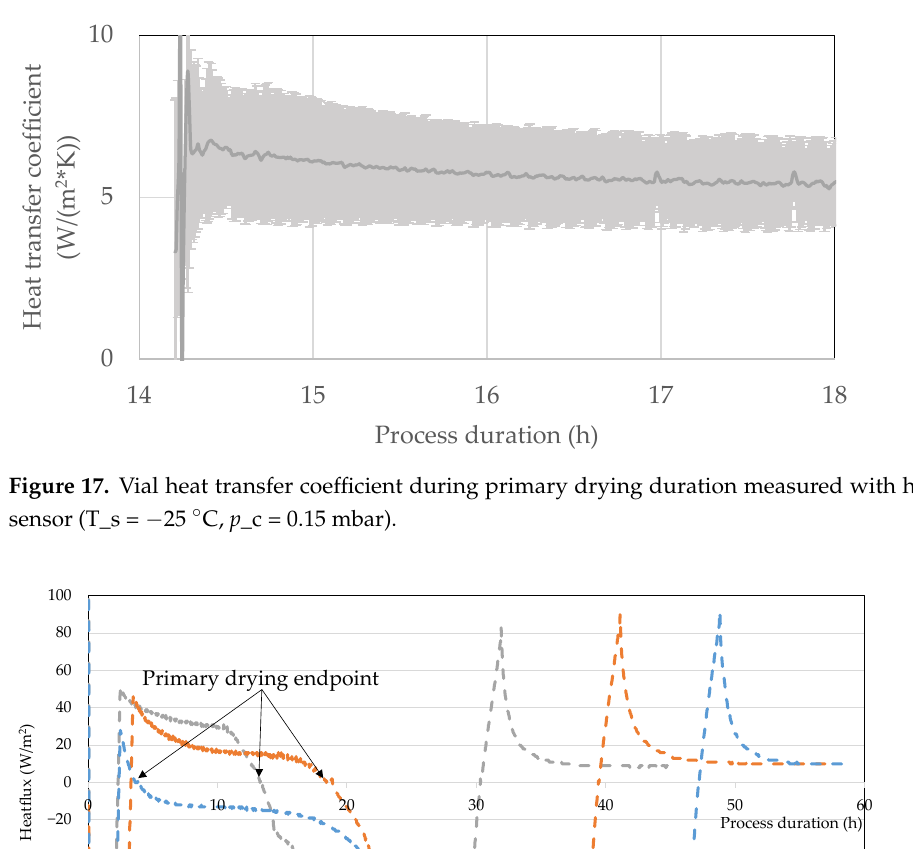
v deviates 60% from the edge vial and around 40% from the center vial K v at